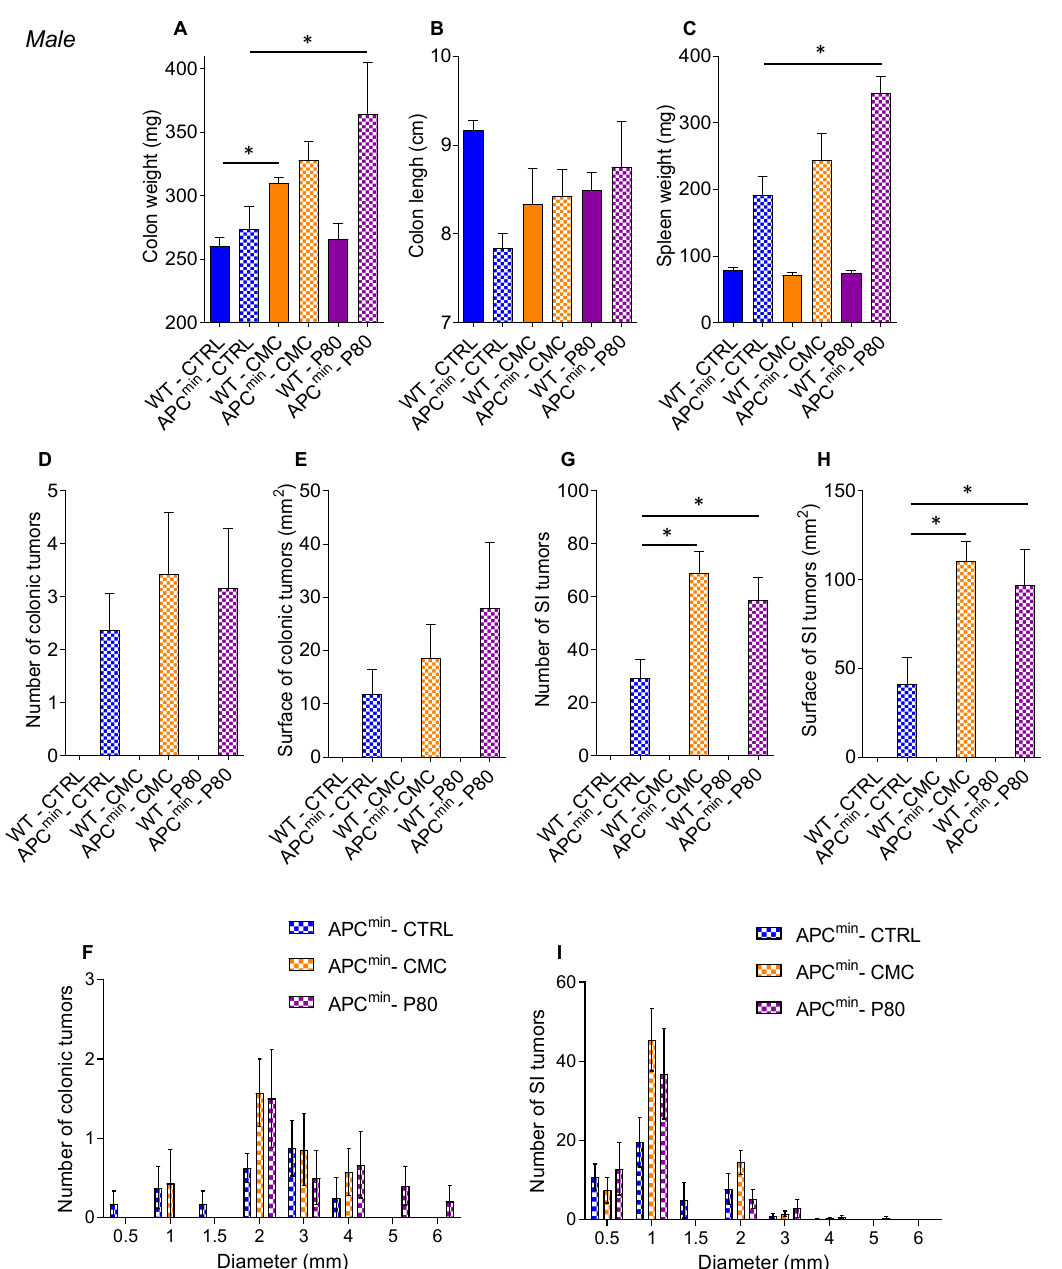
Figure 2. Dietary emulsifier consumption promotes intestinal tumors in APC min male mice. Seven-week-old WT and APC min male mice were exposed to drinking water containing CMC or P80 (1.0%) for 15 weeks. ( A ) Colon weights, ( B ) colon lengths, ( C ) spleen weights, ( D ) number of colonic tumors, ( E ) total colonic tumor surface determined with an ocular micrometer-fitted dissecting microscope, ( F ) number of colonic tumors based on their size, ( G ) number of small-intestine tumors, ( H ) total small-intestine tumor surface determined with an ocular micrometer-fitted dissecting microscope, ( I ) number of small-intestine tumors based on their size. Data are the means +/ − S.E.M. ( n = 6 for the WT–CTRL group, 6 for the APC min –CTRL group, 5 for the WT–CMC group, 7 for the APC min –CMC group, 7 for the WT–P80 group and 6 for the APC min –P80 group). Significance was determined using one-way group ANOVA with a Bonferroni test (* indicates statistical significance).